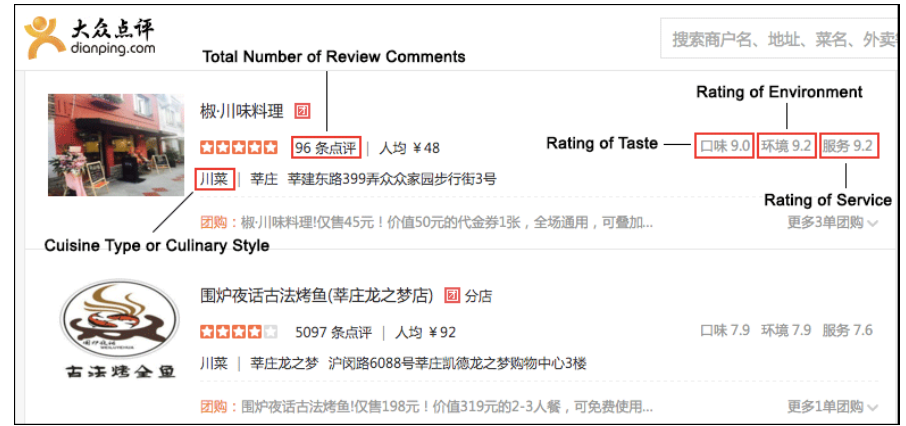
Figure 2. Information of restaurants captured from Dianping (e.g., cuisine type or culinary style, total number of review comments, and rating of taste, environment and